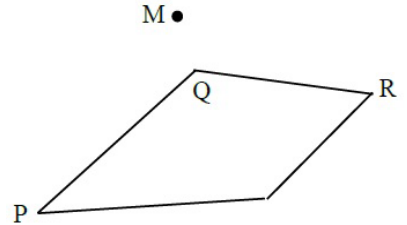
Figure 15: New point appears.